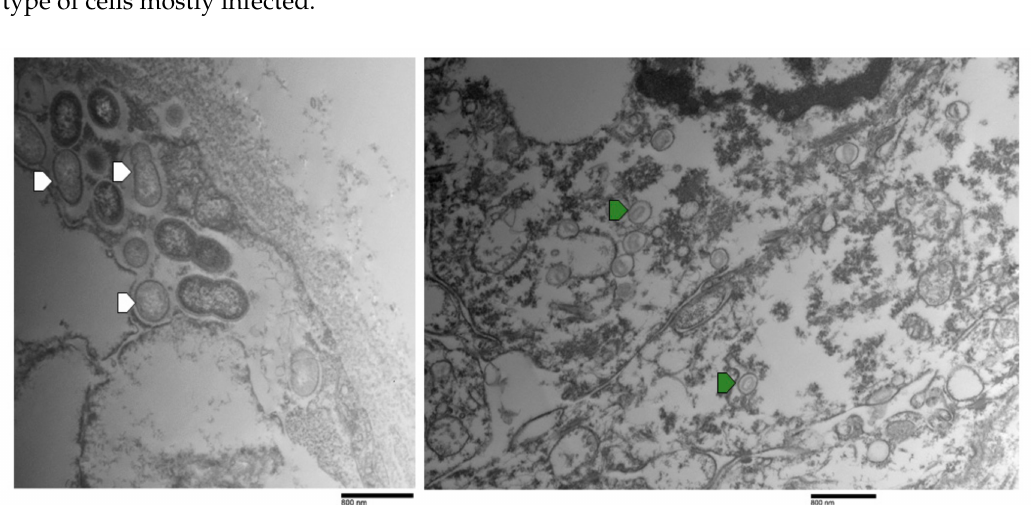
Figure 7. Transmission electron microscopy (TEM) micrographs. On the left, a lung cut from Female 1. At right, an eyelid epithelium cut from Female 1. White arrow heads indicate immature viral particles and green arrow heads indicate apparently mature viral particles. The black bar indicates the scale (800